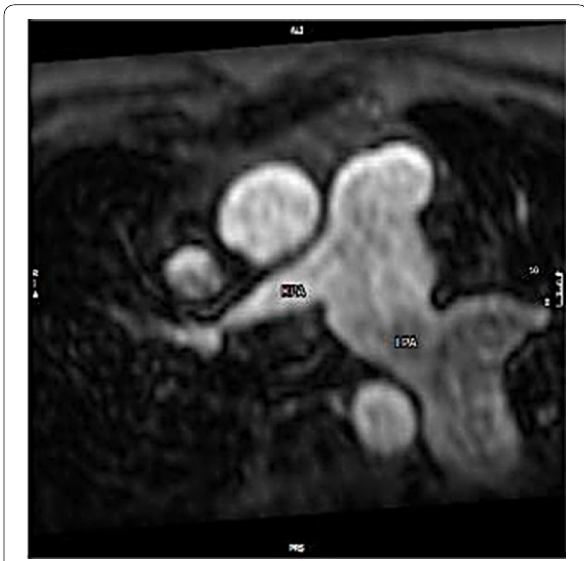
Fig. 19 Still shot post-contrast MR angiogram in the axial view. Residual right branch pulmonary stenosis after TOF repair. RPA: right pulmonary artery; LPA: left pulmonary artery (dilated)